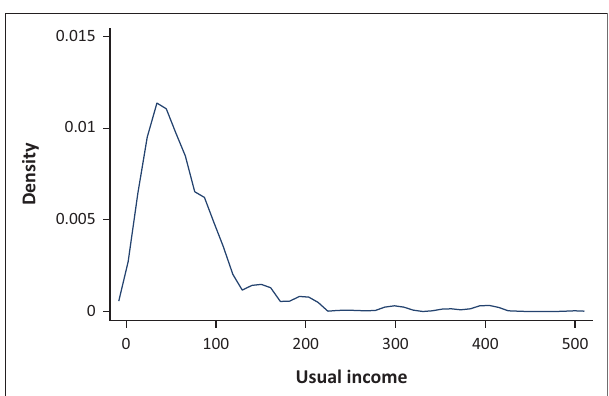
FIGURE 1-A1: Kernel density estimate.